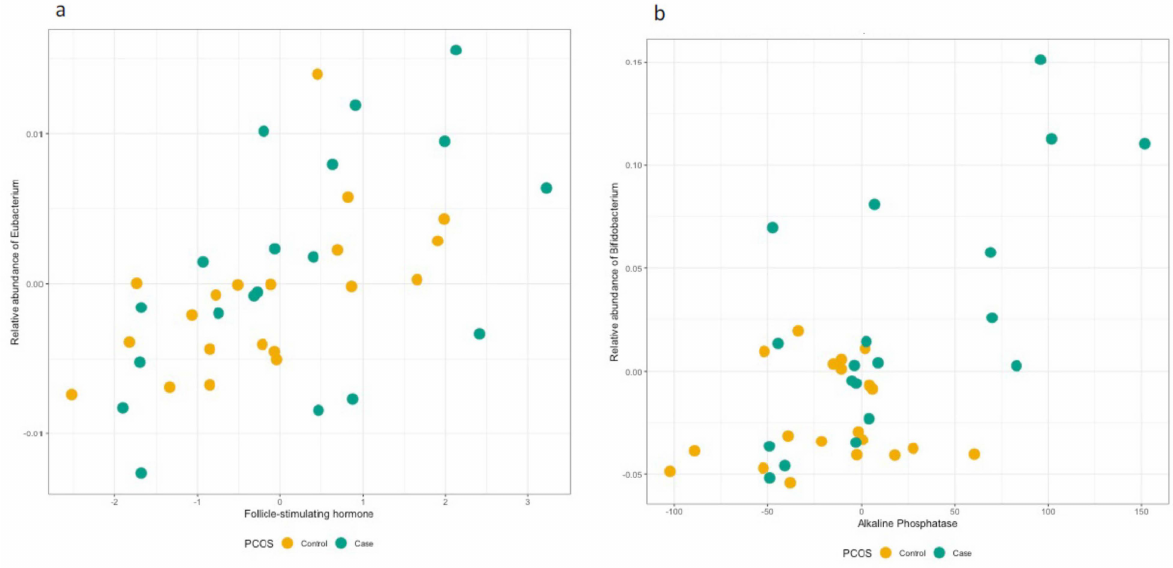
Figure 4. Scatter plots of the relative abundances of ( a ) Eubacterium according to FSH levels, and ( b ) Bifidobacterium according to ALP levels. Individuals with PCOS are depicted with green, and controls with